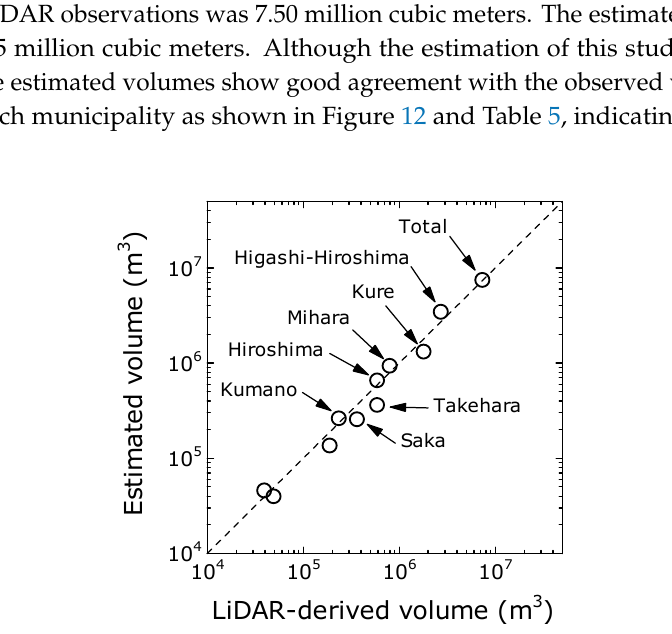
Figure 12. Comparison of LiDAR-derived volumes and estimated volumes based on manual sources in Flow-R analysis for each municipality and total. Table 5. Comparison of volumes in each municipality between LiDAR-observation and estimations of this